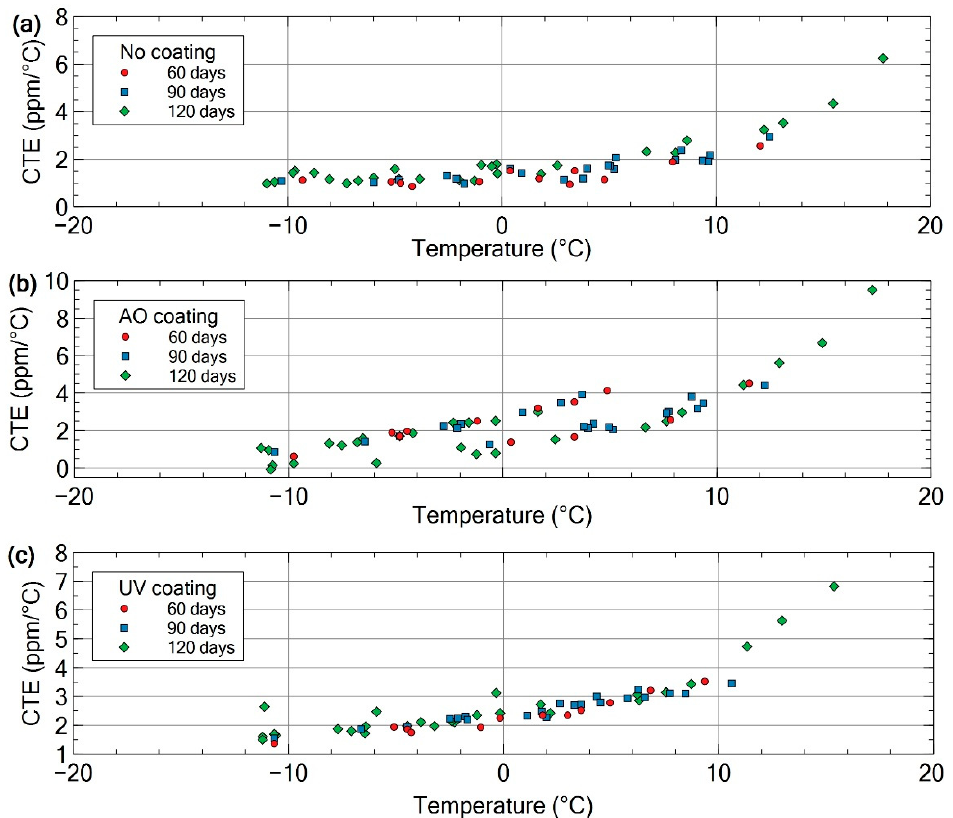
Figure 14. Monthly CTE measurement. ( a ) Sample with no coating; ( b ) sample with atomic oxygen (AO) coating; ( c ) sample with ultraviolet (UV) coating.